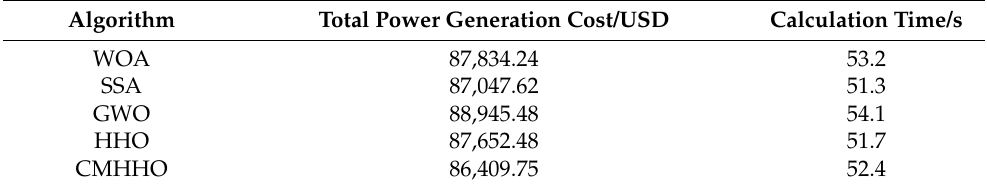
Table 5. Comparison of test results of different algorithms (two-region 6-node interconnected system).